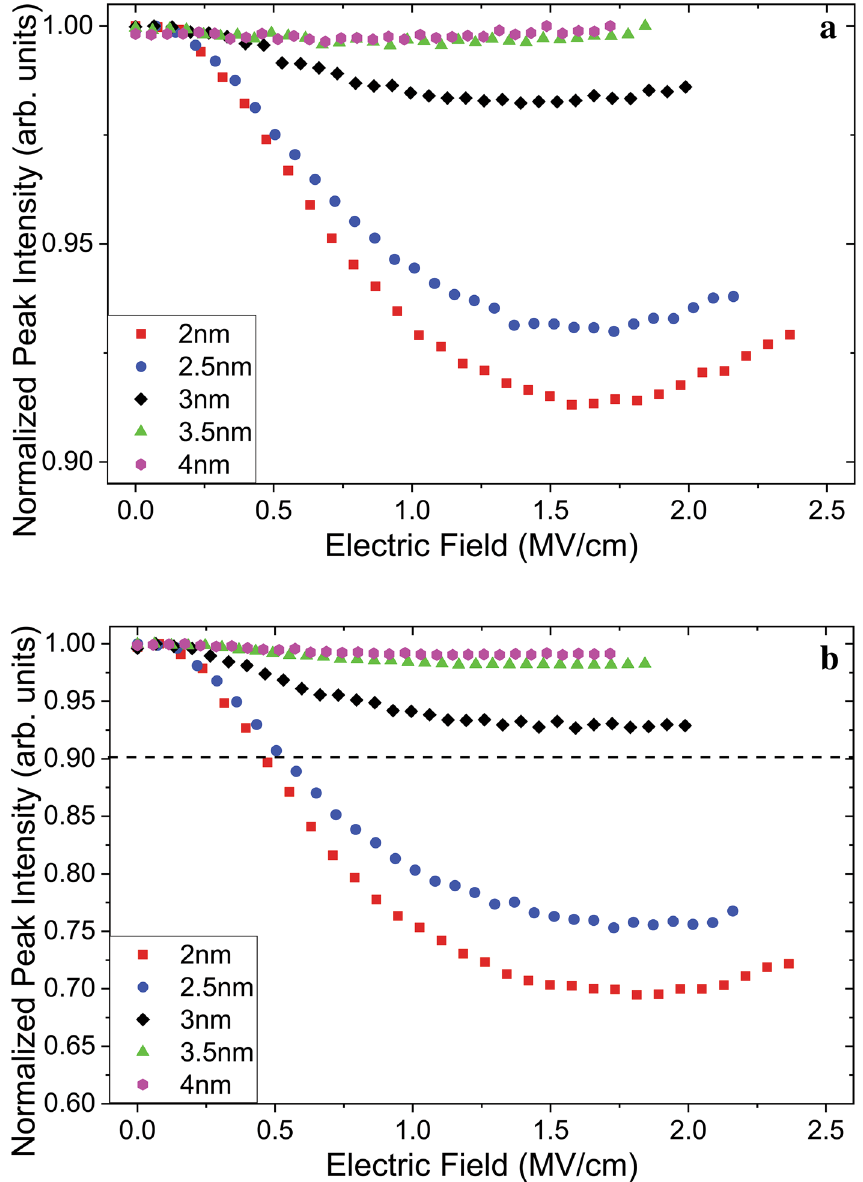
Figure 6. PL intensity–electric field plots as a function of the barrier thickness for the passivated ( a ) and non- passivated ( b ) sample sets, measured at 80 K. The dashed line in ( b ) marks the lower limit of the vertical axis in ( a